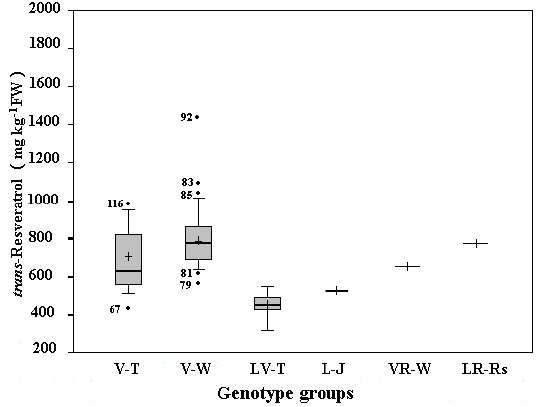
Figure 3. Box and whisker plots of Yantai Grape Germplasm Repository. The median and mean value are indicated by the horizontal bar and the plus sign inside the box, respectively. The height of the box represents the interquartile range (IQR), which is the difference between the third quartile and the first quartile of the data. The whisker (the vertical lines from the top and bottom of the box) extends to a distance of 1.5 times IQR. Data outside these whiskers are marked by the black dots. The numbers in front of the black dots represent the accession numbers (Table 1). V-T, table grape cultivars of V. vinifera ; V-W, wine grape cultivars of V. vinifera ; LV-T, table grape cultivars of hybrids between V. labrusca and V. vinifera ; L-J, juice grape cultivars of V. labrusca ; VR-W, wine grape cultivar of hybrid between V.vinifera and V. riparia. LR-Rs, rootstock grape cultivar of hybrid between V. labrusca and V. riparia